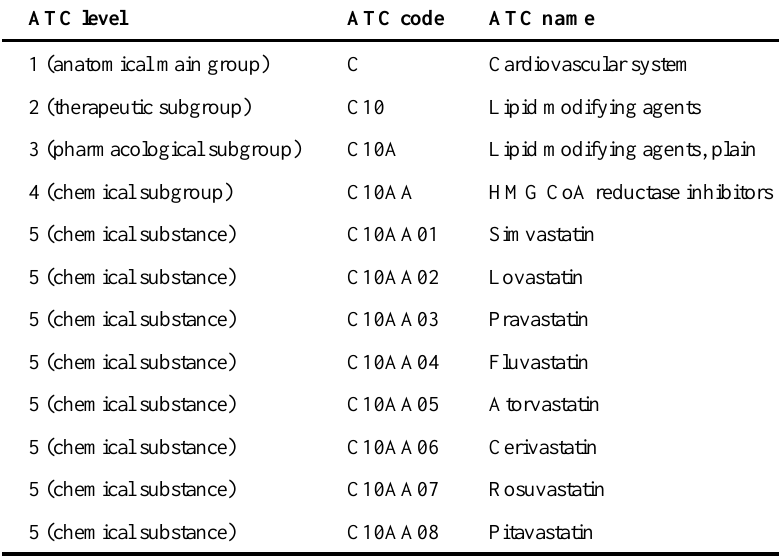
Table 1: Chemical substances in chemical subgroup C10AA (HMG CoA reductase inhibitors) and the ATC codes and names of their “parents” ATC level ATC code ATC